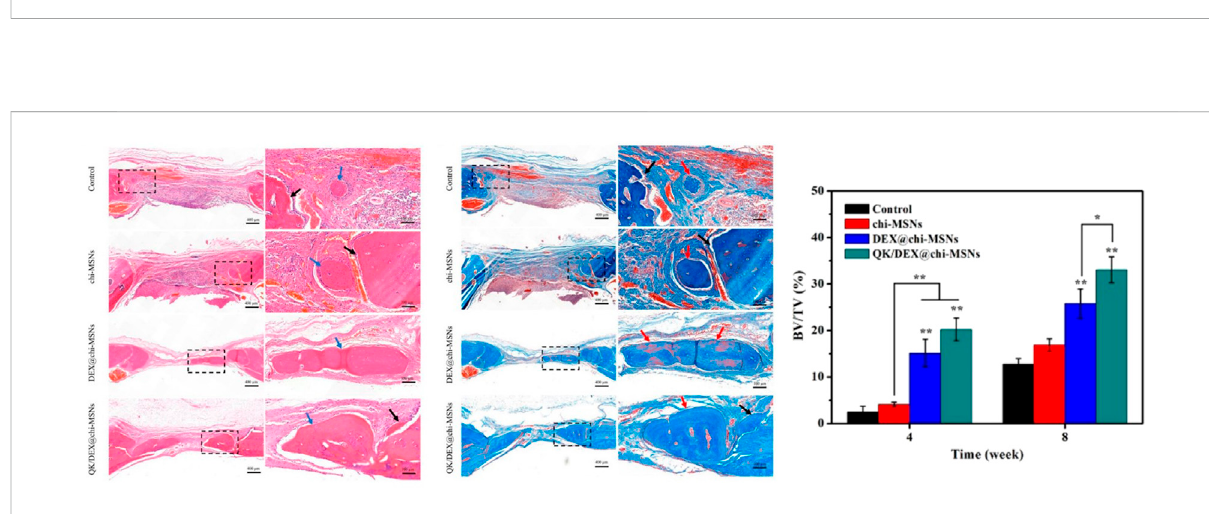
FIGURE 3 Comparative H&E and Masson ’ s trichrome stains characterizing new bone formation in rat cranial bone defects treated with small molecule dexamethasone (DEX)-incorporating gelfoams (DEX/@chi-MSNs; QK/DEX@chi-MSNs) in addition to DEX-devoid gelfoams (Control; Chi-MSNs), 8 weeks after placement within defect. Blue arrow represent new bone, while black arrows represent incumbent host bone. Using CT-Analyser Software,elevatedbonevolume/totalvolumeratiosweremeasuredintreatmentgroupsincorporatingDEX.Reproducedfrom(Sunetal.,2019)